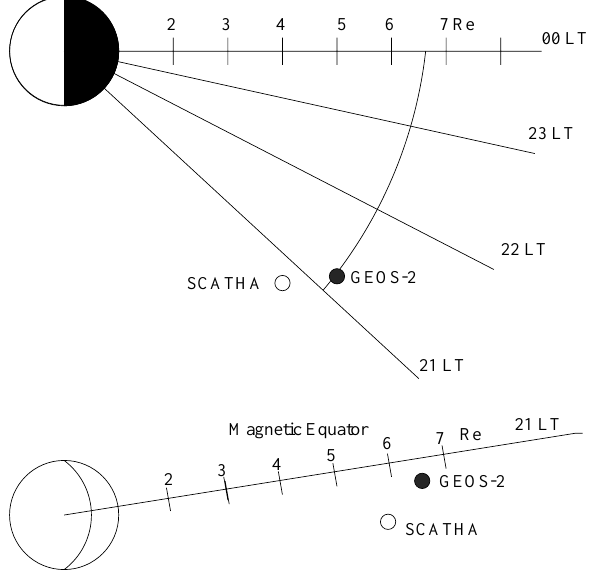
Fig. 1. Schematic illustration of GEOS-2 and SCATHA positions in the equatorial and meridian planes on 22 May 1979 at 18:40